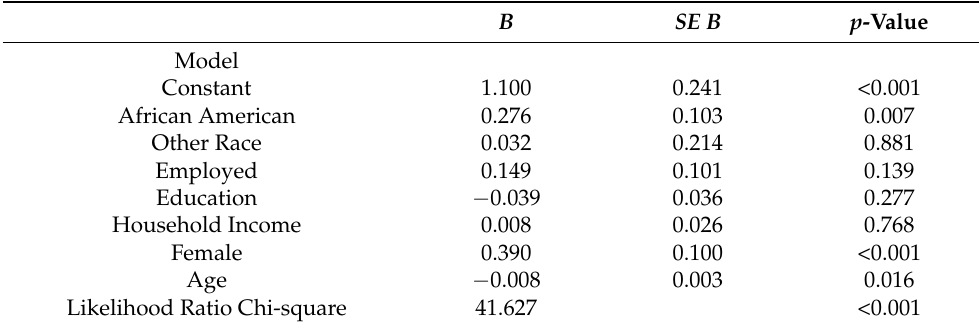
Table 3. Negative Binomial Regression Coefficients to Predict Number of Media Exposure to Breast- feeding Promotion with Multiple Imputation ( n =